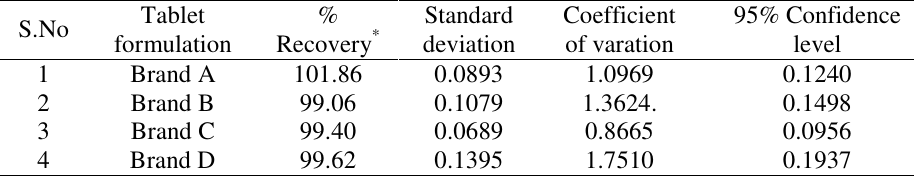
Table 3. Recovery